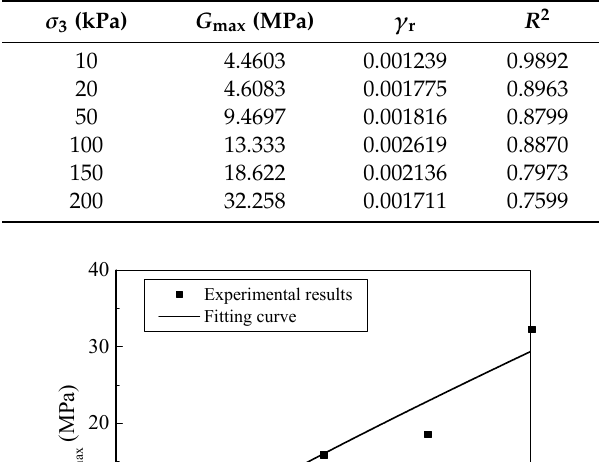
Table 5. Fitted maximum shear modulus and reference shear strain for various confining pressures.